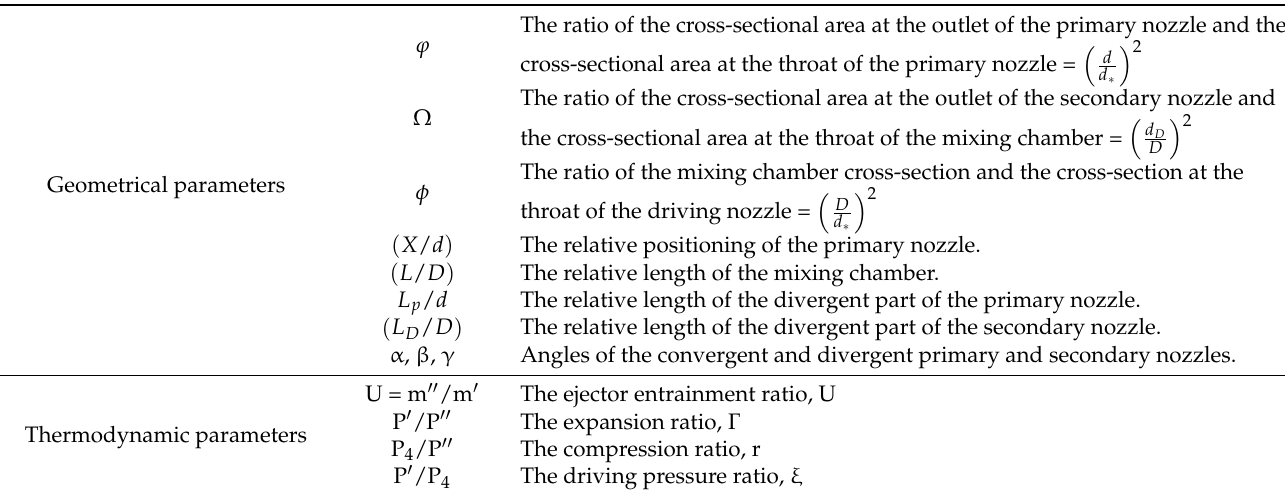
Table 2. The geometrical and thermodynamic parameters of the ejector.